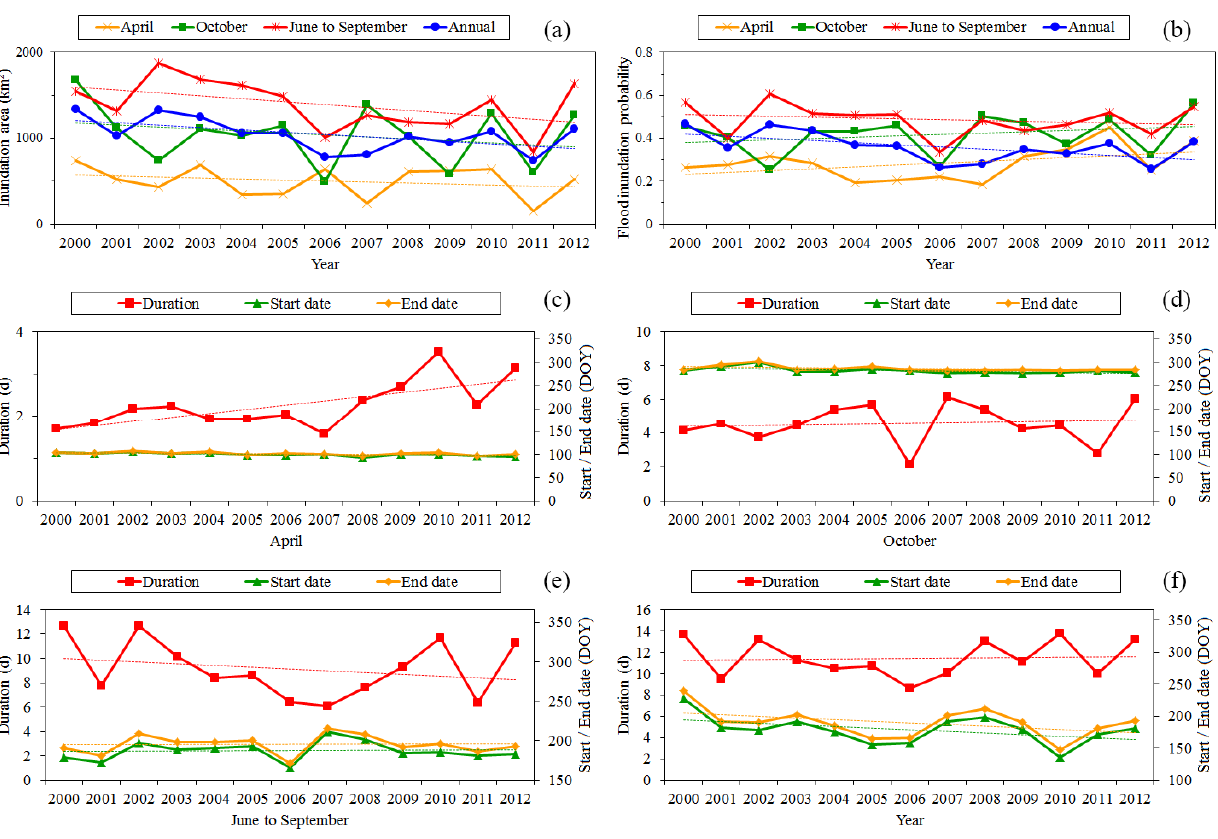
Figure 12. ( a ) Development of average inundation areas in April, October, June to September and each year from 2000 to 2012 in the Dongting Lake; ( b ) Development of average flood inundation probability in April, October, June to September and each year between 2000 and 2012; ( c ) Development of the average duration and start/end date of the largest flood in April during 2000 to 2012; ( d ) Development of the average duration and start/end date of the greatest flood in October from 2000 to 2012; ( e ) Development of the average duration and start/end date of the largest flood in June to September between 2000 and 2012; ( f ) Development of the average annual duration and start/end date of the greatest flood during 2000 to 2012. The dotted lines denote their development